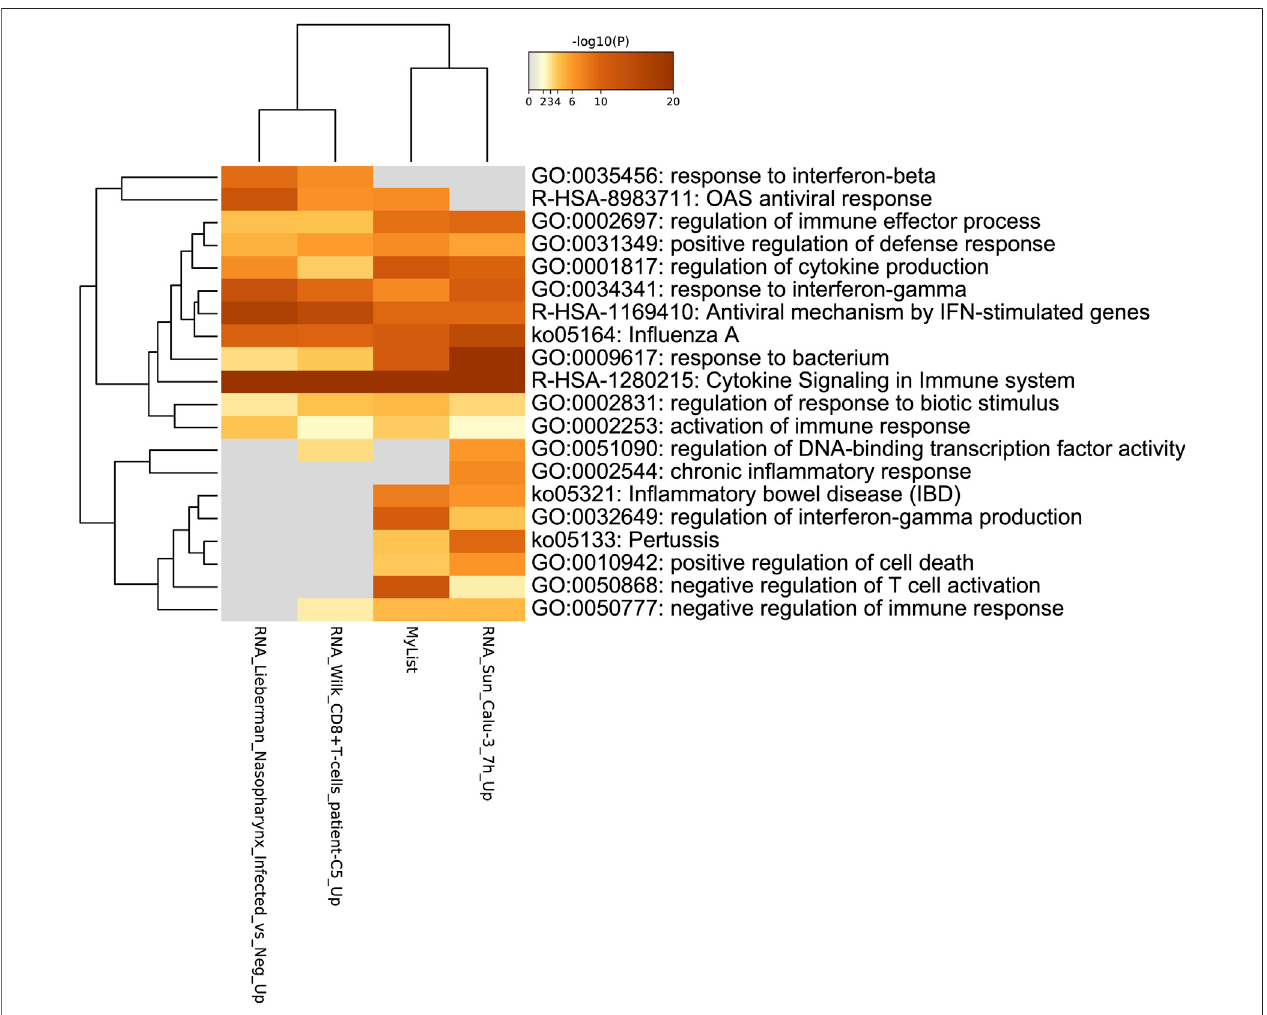
FIGURE5| GenetermenrichmentagainstCOVID-19referencelistfortheDEGsinCOVID-19revealthatthereactomegenesetsforcytokinesignalingareinvolved in COVID-19 prognosis.